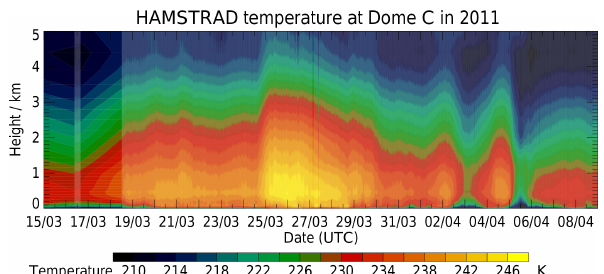
Figure 5. Time evolution of temperature from 15 March to 8 April 2011 above Dome C as measured by the HAMSTRAD radiometer from 0 to